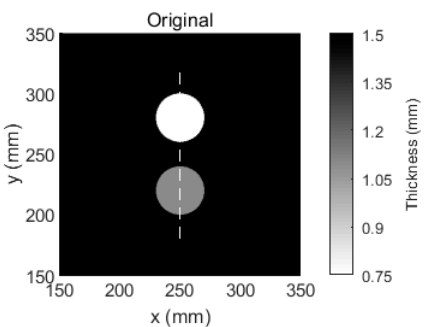
Figure 7. Aluminum plate with a thickness of 1.5 mm and two 40-mm-diameter circular flat-bottomed holes. Their thickness losses are 50% and 30% within the flaws.